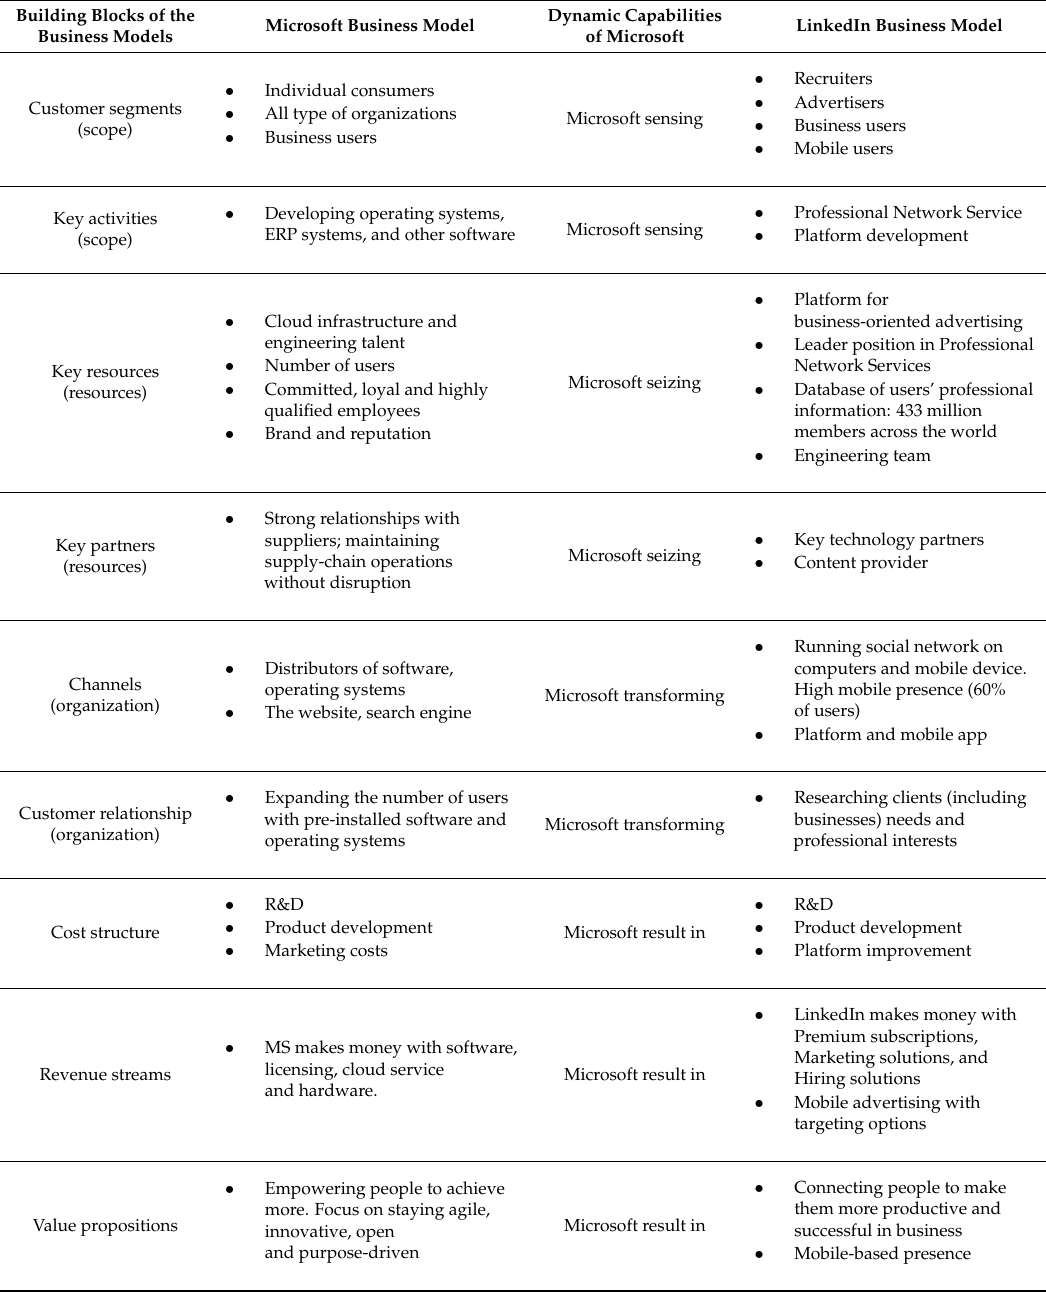
Table 7. The role of dynamic capabilities of Microsoft as drivers of the business model innovation by acquiring